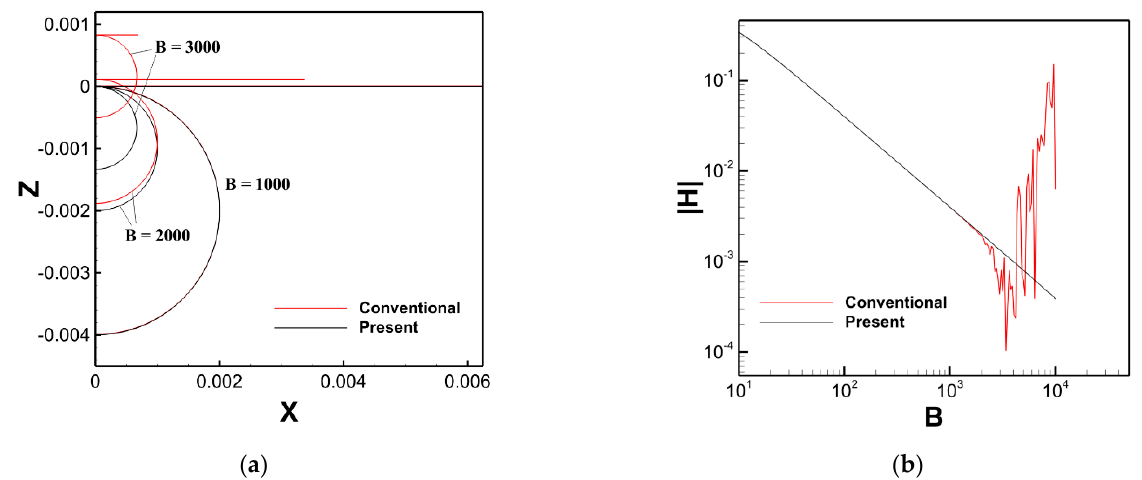
Figure 6. Comparison of the conventional (red) and the improved (black) methods for small bubbles. The tolerance of the ODE solver is set to 10 − 12 . ( a ) Floating bubble shapes for the following three small bubble sizes: B = 1000, 2000, and 3000. ( b ) The dimensionless absolute height | H | is plotted with respect to the parameter B